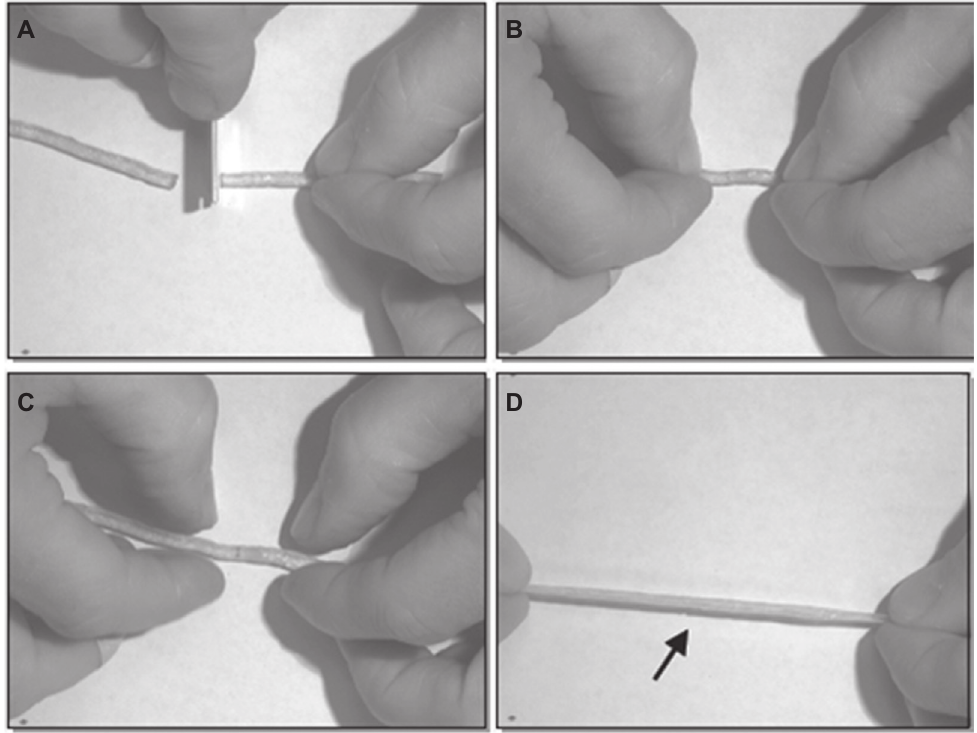
Figure 13 Sequential images of the self-healing test of a supramolecular rubber (A – D, cut, join, mend, and stretch, reprinted with permis- sion from [63]). Copyright 2008, Ludwik Leibler, CNRS.